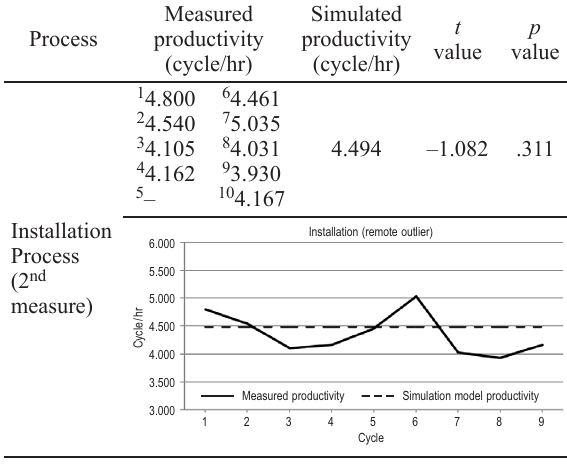
Table 9. T-test results between the measured and simulated productivity in the installing process (2 nd measure)